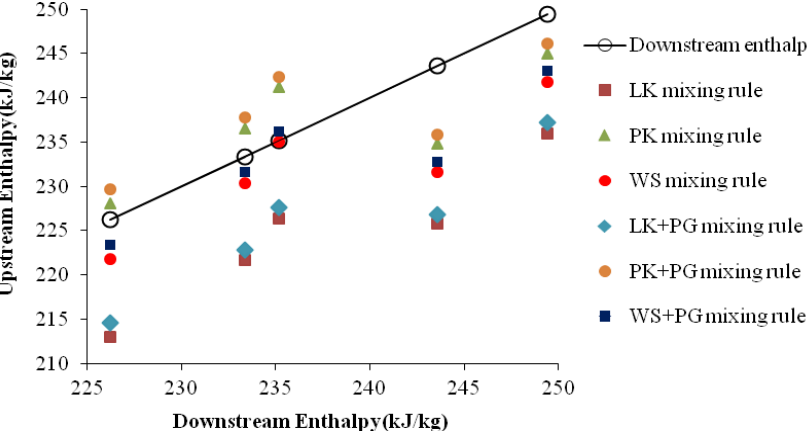
Figure 2. Comparison between the upstream and downstream